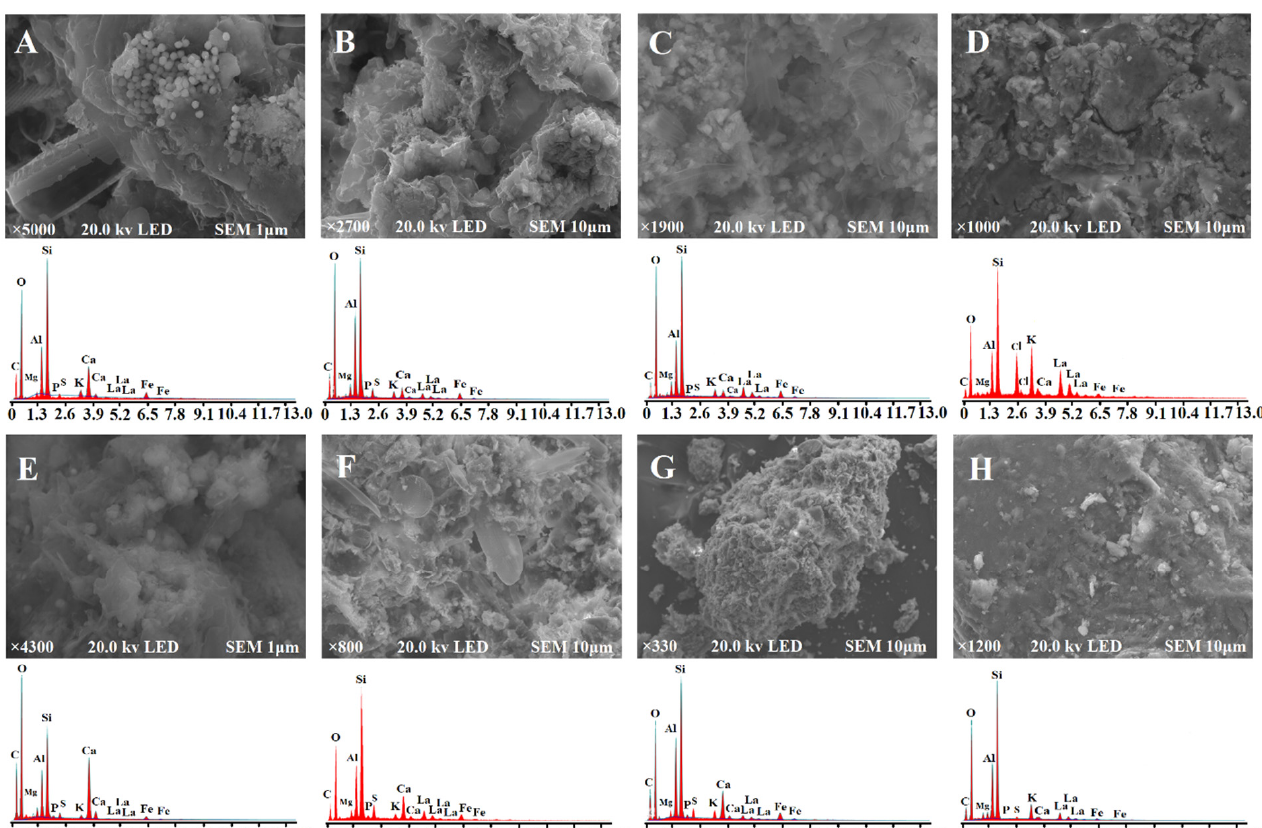
Figure 3. SEM images and spectra of chemical composition of Control ( A ), LAA ( B ), LAA+M ( C ), Original LAA ( D ), M ( E ), LMB ( F ), LMB+M ( G ) and Original LMB ( H ). Original LAA and Original LMB are substances that are not mixed with sediments respectively.